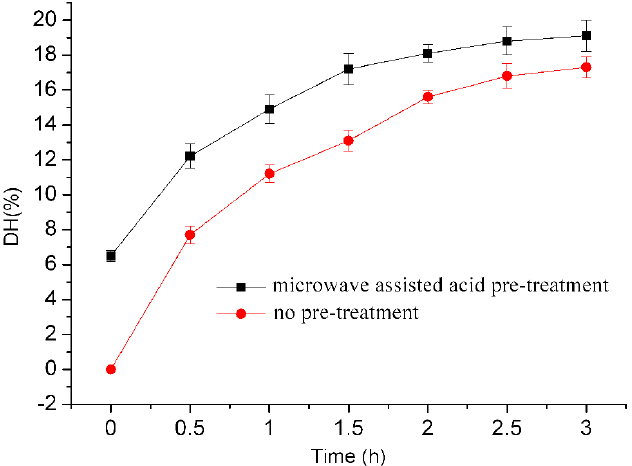
1. Degree of hydrolysis with microwave acid-pretreatment and without (non-pretreated), with no nitrogen protection of bone collagen, using Neutral proteinase, at the indicated times. Results are presented as the means (n = 3) ± SD. The data mean is significantly different at ( P <